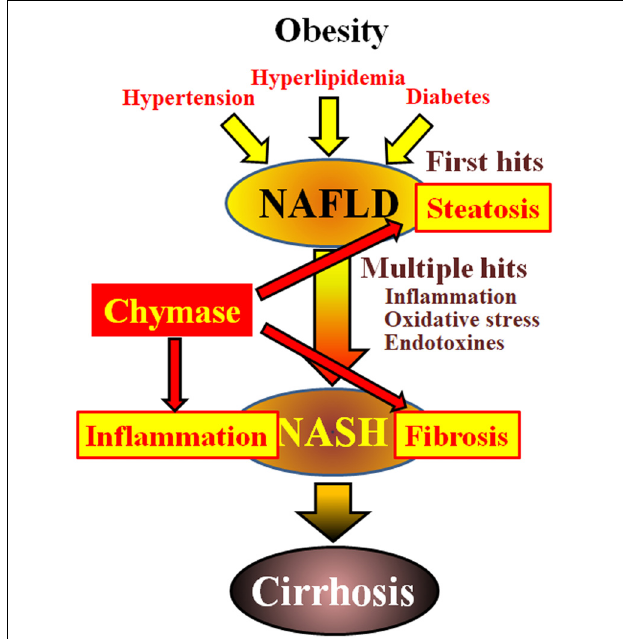
FIGURE 1 | NAFLD and NASH are linked to metabolic syndrome by obesity, insulin resistance, hyperlipidemia, and hypertension. NASH is thought to develop via a ‘multiple-hit’ process, with hepatic steatosis as the “first hit” and subsequent hits such as inflammation, oxidative stress and endotoxins, and is characterized by severe steatosis, inflammation, and fibrosis. Chymase may be involved in the progression of steatosis, inflammation, and fibrosis in liver.